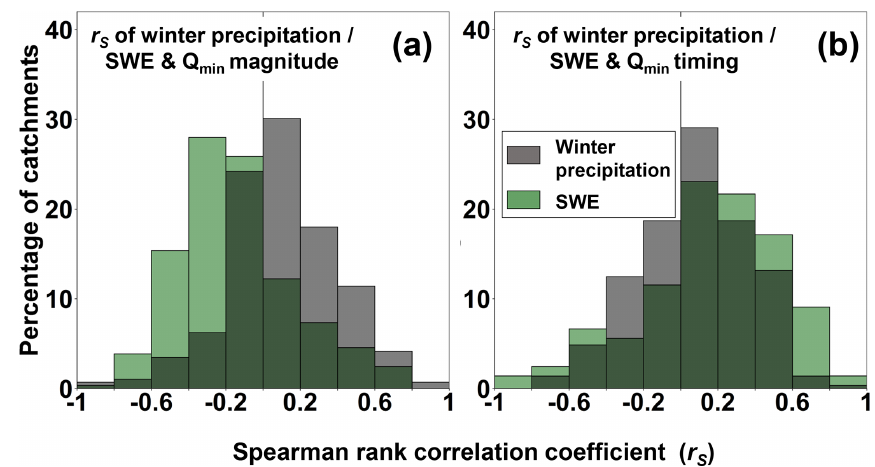
Figure 8. Histograms of the rank correlations between winter precipitation (December through March; gray bars), the 1 March snow water equivalent (SWE; green bars) and the magnitude (a) and timing (b) of warm-season low flows. Winter precipitation is weakly associated with higher, and later, warm-season low flows, as indicated by the positive r S for the majority of catchments; however, correlations are weak overall, with considerable site-to-site